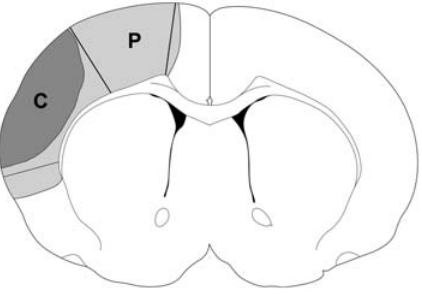
Figure 3. The definition of the ischemic penumbra and core. The gray region (p) plus the black region (C) represent ischemic injury in a control rat with ischemia alone; C represents infarction in a rat that received ischemia plus postconditioning. The region P spared by postconditioning is defined as the penumbra and the region C is defined as the ischemic